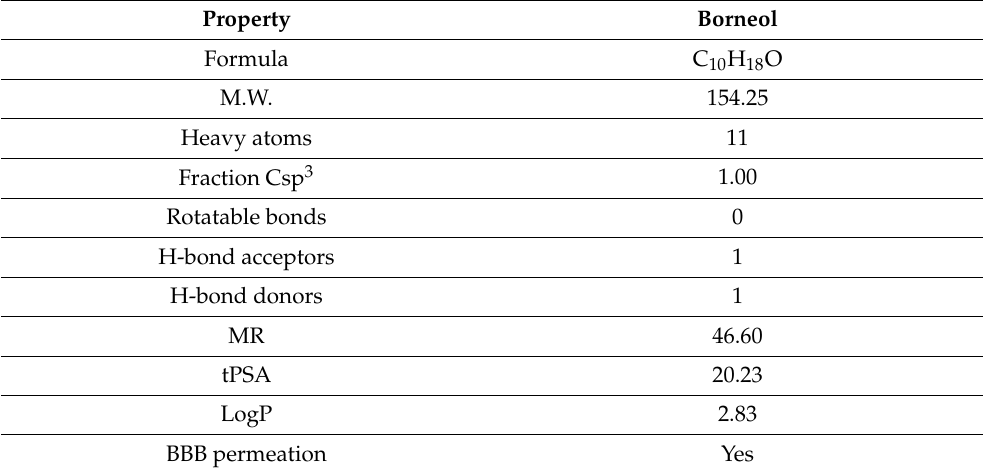
Table 4. Physicochemical properties of borneol, according to SwissADME results and binary classifi- cation tree model.